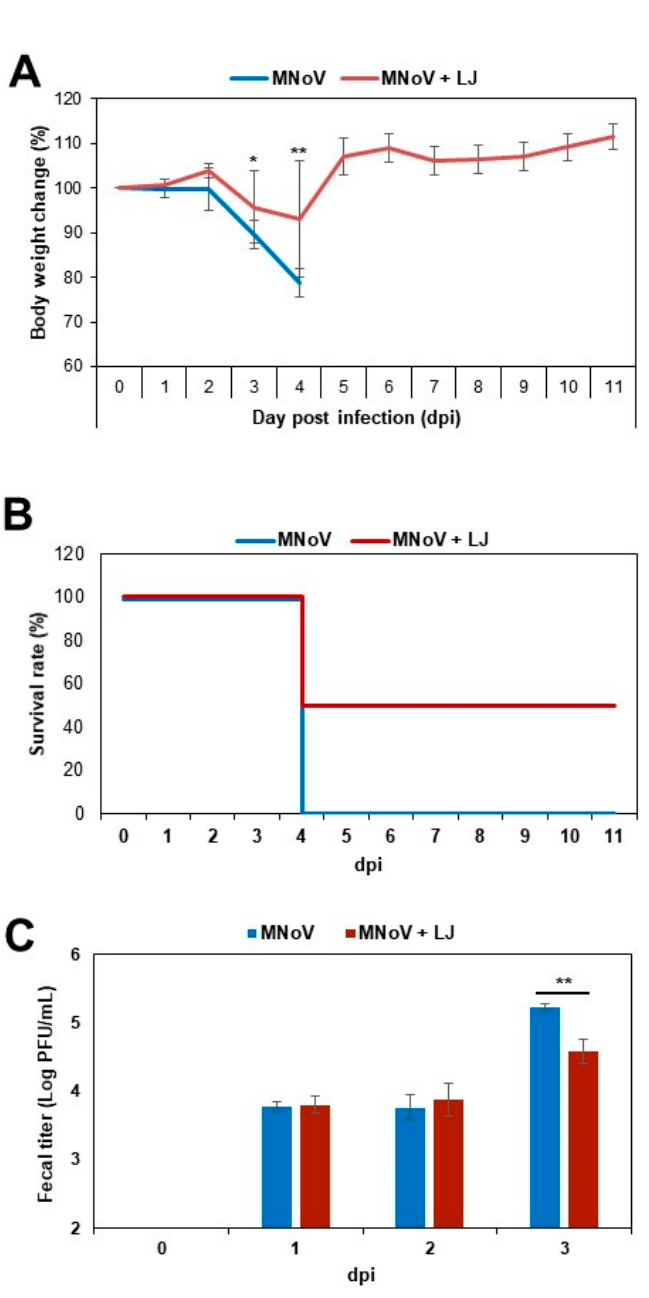
Figure 2. In vivo efficacy of fucoidans of Laminaria japonica (LJ). ( A ) Body weight changes, ( B ) survival rate until 11 dpi and ( C ) fecal viral titers. STAT1 − / − mice were inoculated perorally with 3 × 10 4 PFU of MNoV and a dose of 40 mg fucoidan / kg / day (n = 4 per group) was administered by oral gavage immediately after infection until 4 days post-infection (dpi). A PBS group was used as control. Asterisk indicates significant difference (* p < 0.05; ** p < 0.01).